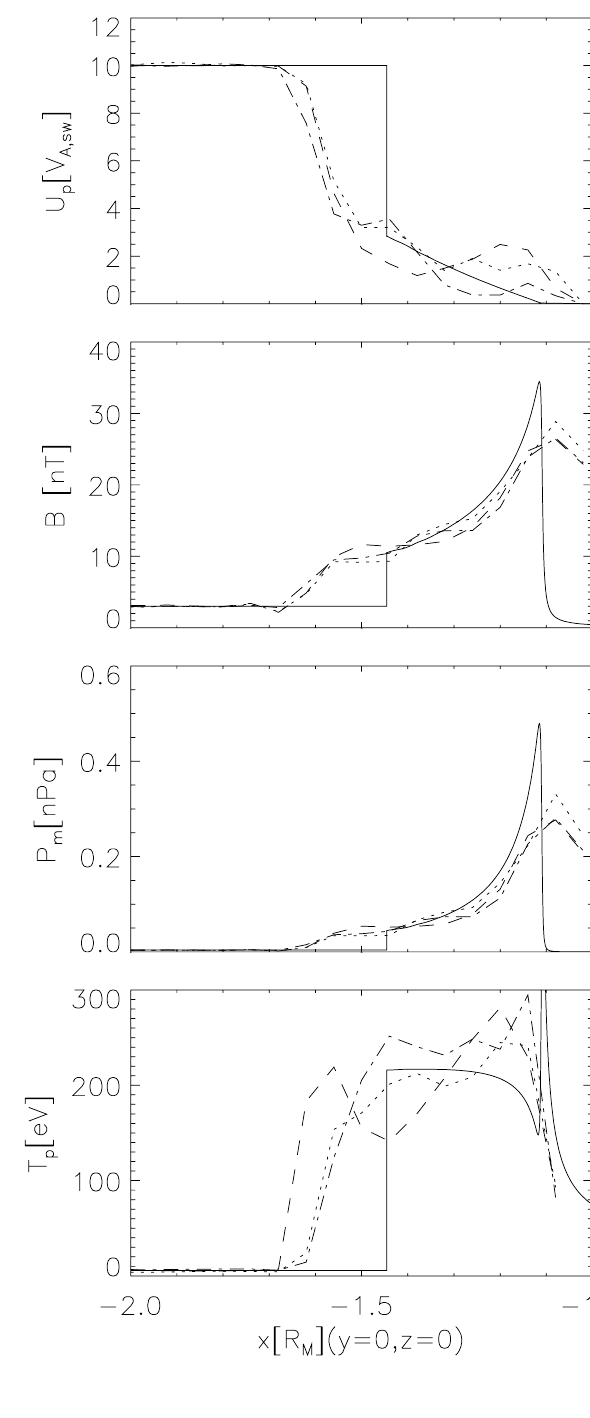
Fig. 2. Comparison of MHD and hybrid magnetosheath profiles along the subsolar